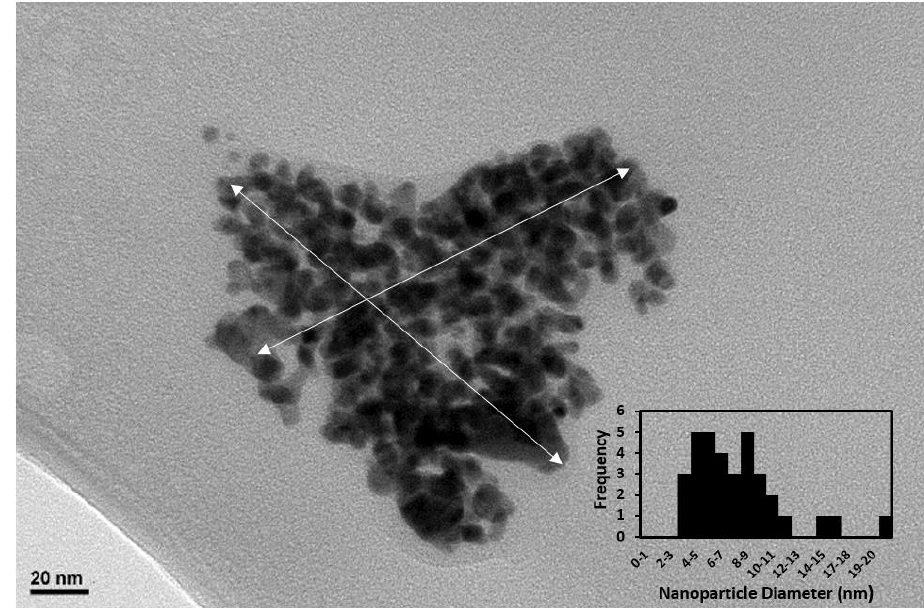
Figure 5. TEM micrograph of the BCD–AuNPs network and an inset showed that the histogram indicated the average diameter of gold nanoparticle is 7.7